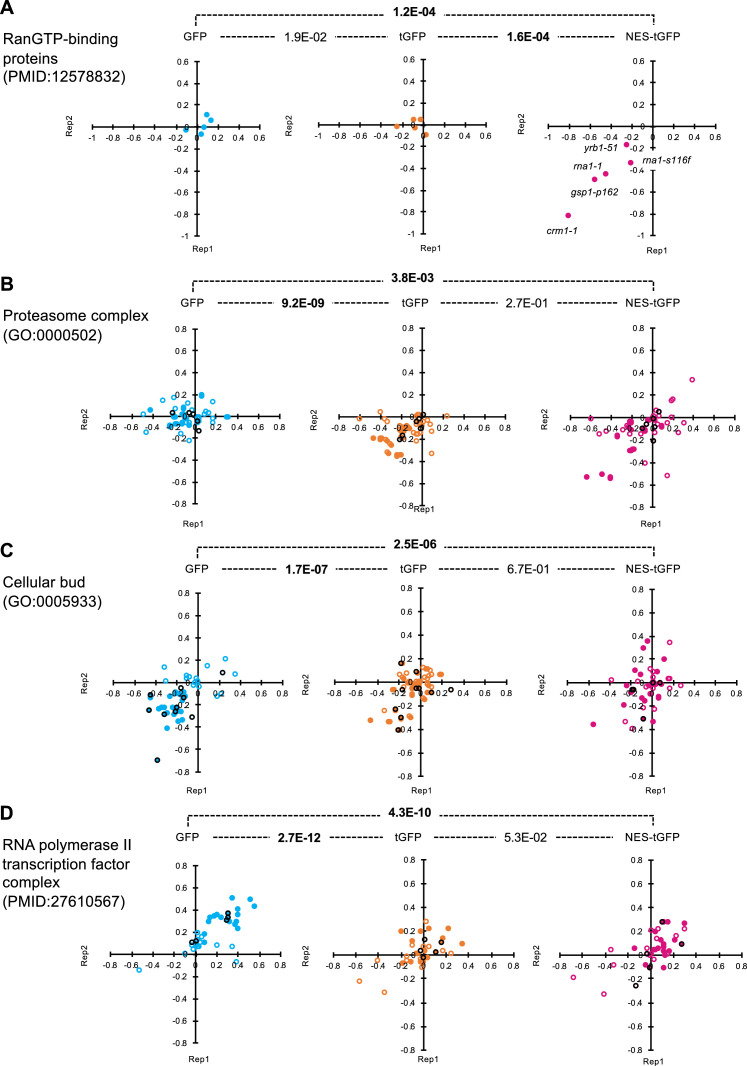
Distributions of GI scores of mutants in specific publications and GO.GI scores of mutants in the indicated publications (A and D) and GO terms (B and C) from the duplicated experiments on GFP-op, tGFP-op, and NES-tGFP are shown as scatter plots. All circles represent the analyzed mutants in the indicated categories, and the filled circles represent those with GI scores below or above the thresholds in any of the three experiments. Black circles indicate deletion mutans of non-essential genes, and other-colored circles indicate temperature-sensitive mutans of essential genes. The p-values of pair-wise t-test between experiments are shown. Bold letters indicate significant p-values (p<0.001).Figure 5—figure supplement 1—source data 1.Raw data of tGFP-op SGA analysis; associated with Figure 5—figure supplement 1A–D.Figure 5—figure supplement 1—source data 2.Raw data of NES-tGFP-op SGA analysis; associated with Figure 5—figure supplement 1A–D.